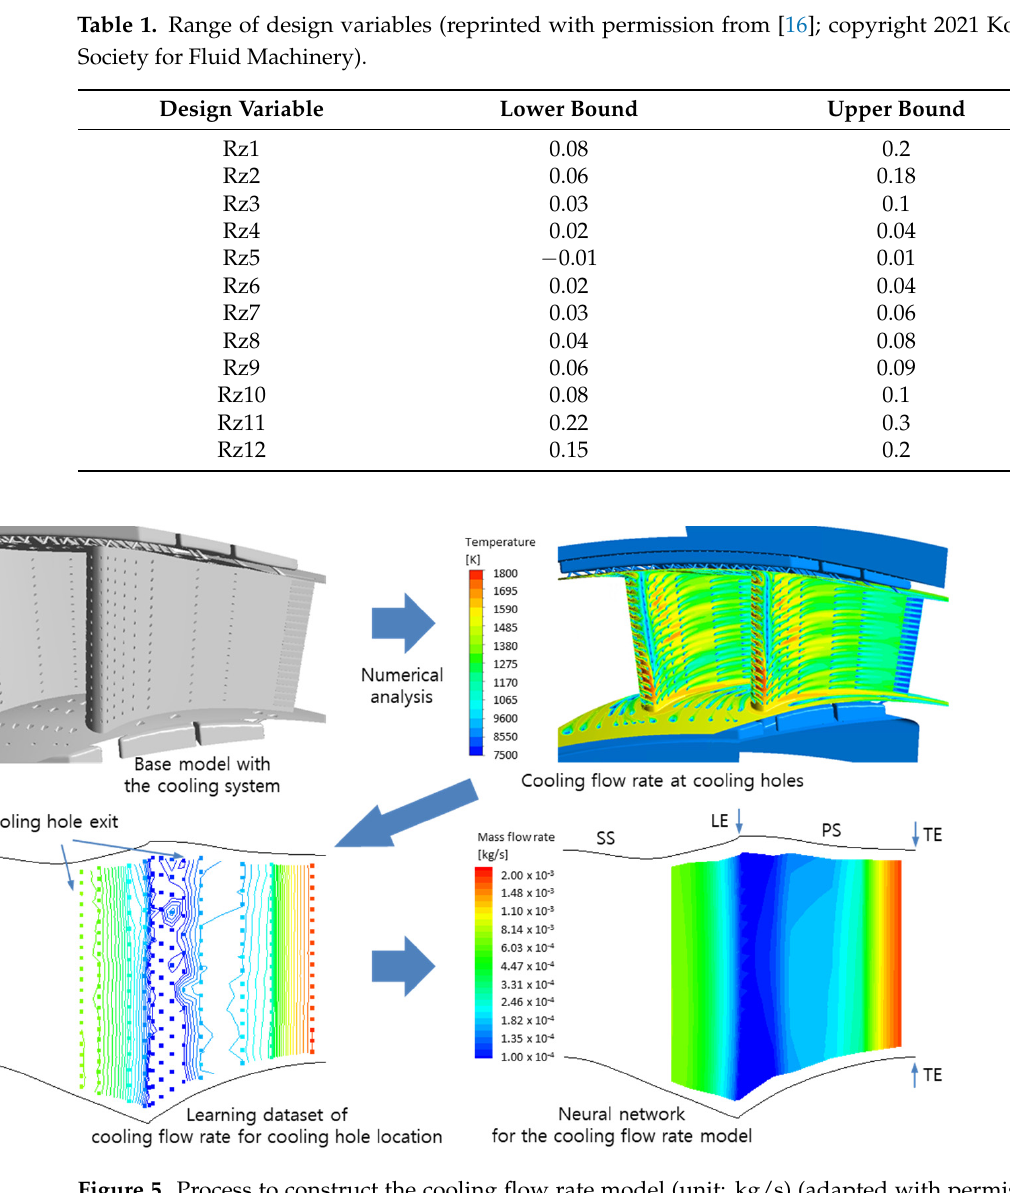
Figure 5. Process to construct the cooling flow rate model (unit: kg/s) (adapted with permission from [16]; copyright 2021 Korean Society for Fluid Machinery).